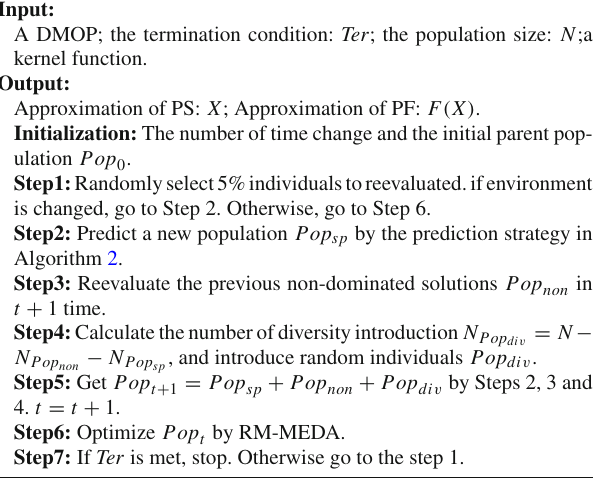
and the offspring is produced by sampling on multiple linear